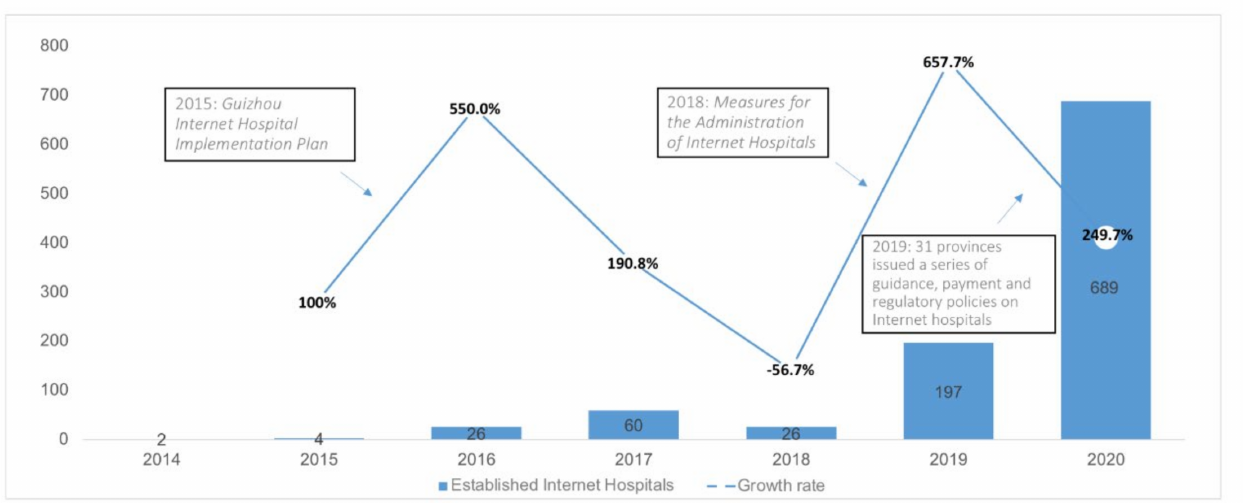
Figure 7. Policies issued by the government and established Internet hospitals in China, 2014–2019. Adapted from source: National Telemedicine Center of China